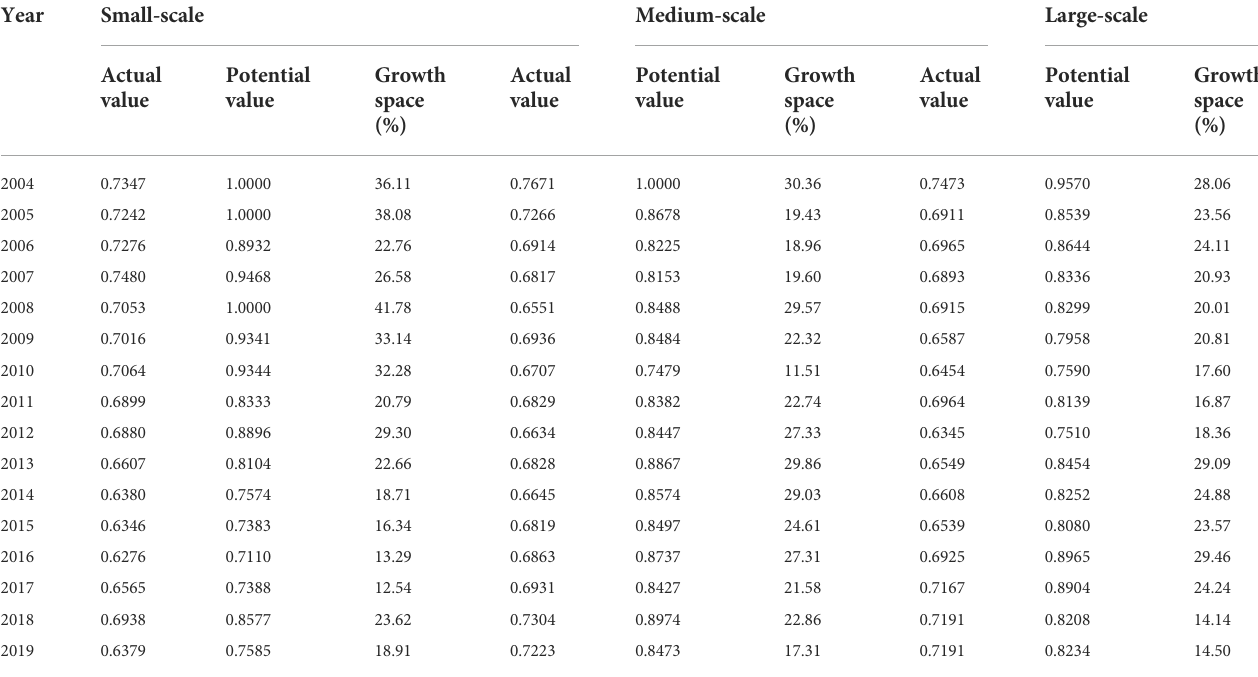
TABLE 7 Growth space of environmental ef fi ciency of dairy farming on different